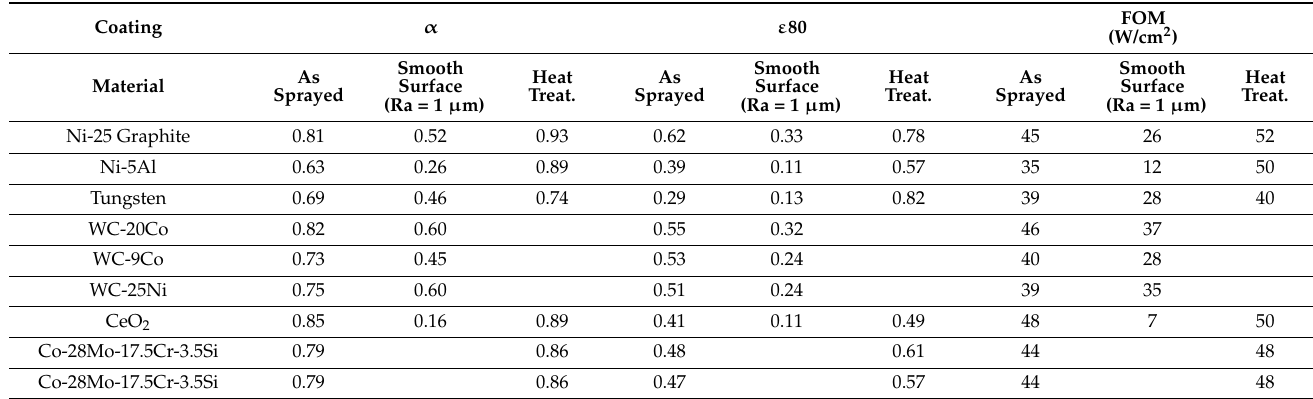
Table 1. Absorptance and emittance data for coatings with as-sprayed, with 1 µ polished, and with as-sprayed heat-treated surfaces (data from